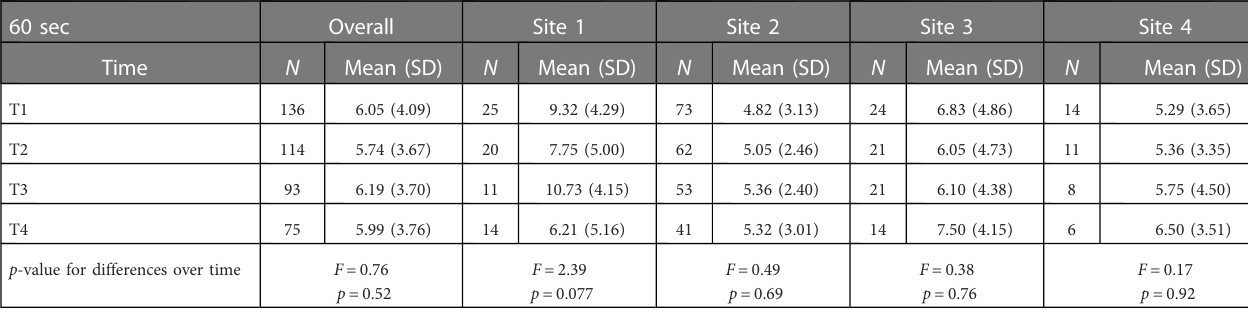
TABLE 3 PIPP-R scores at 60 seconds after the procedure over time. 60